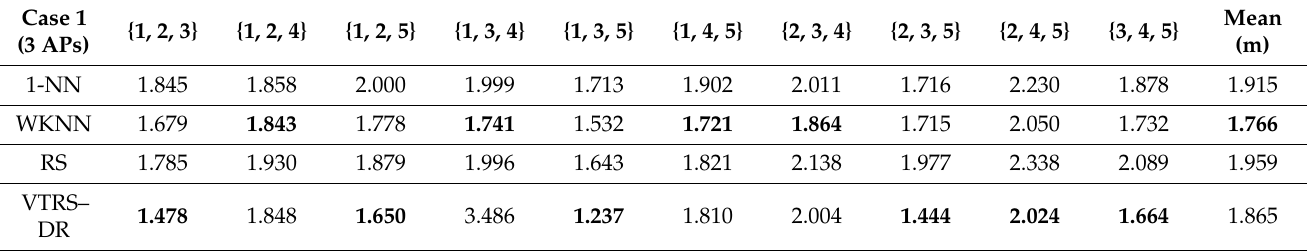
Table 10. Mean errors of using three APs in Case 1.